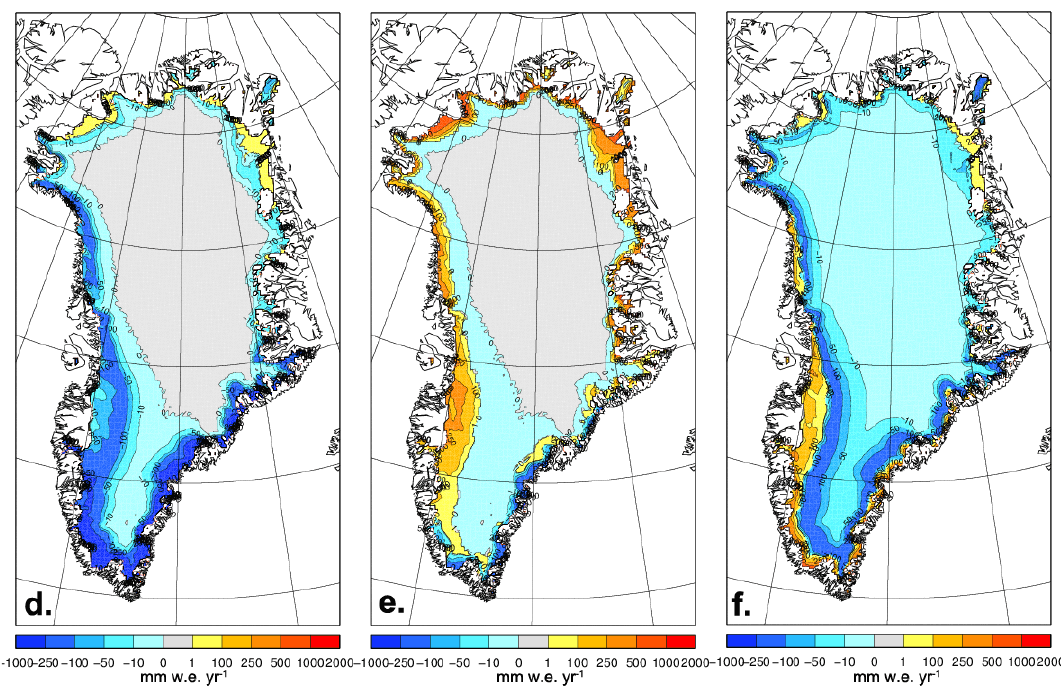
Fig. 7. Difference between RACMO2 modelled refrozen mass ( E r ) and parameterized amount (Param.–RACMO2). (a) Re1991, (b) Pf1991, (c) JH2000, (d) HdW1999, (e) Wr2007, (f) Oe1991.